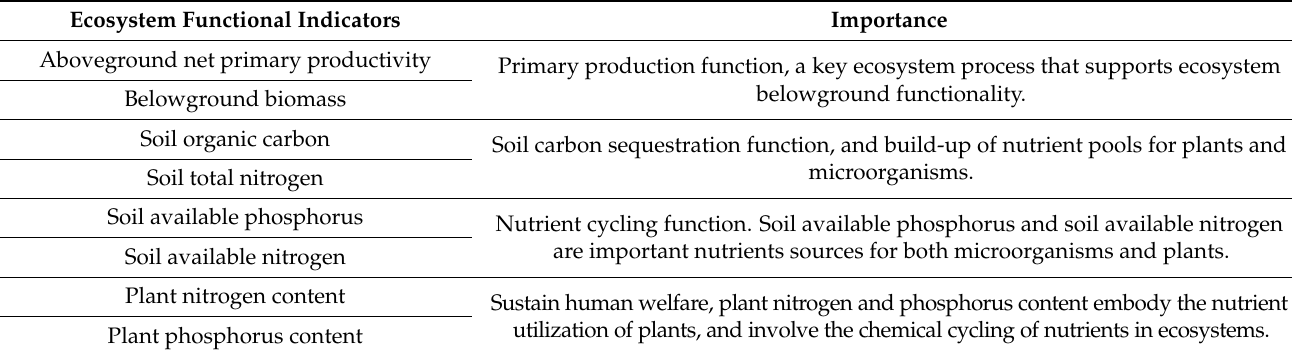
Table 4. The information on all ecosystem function indicators and their